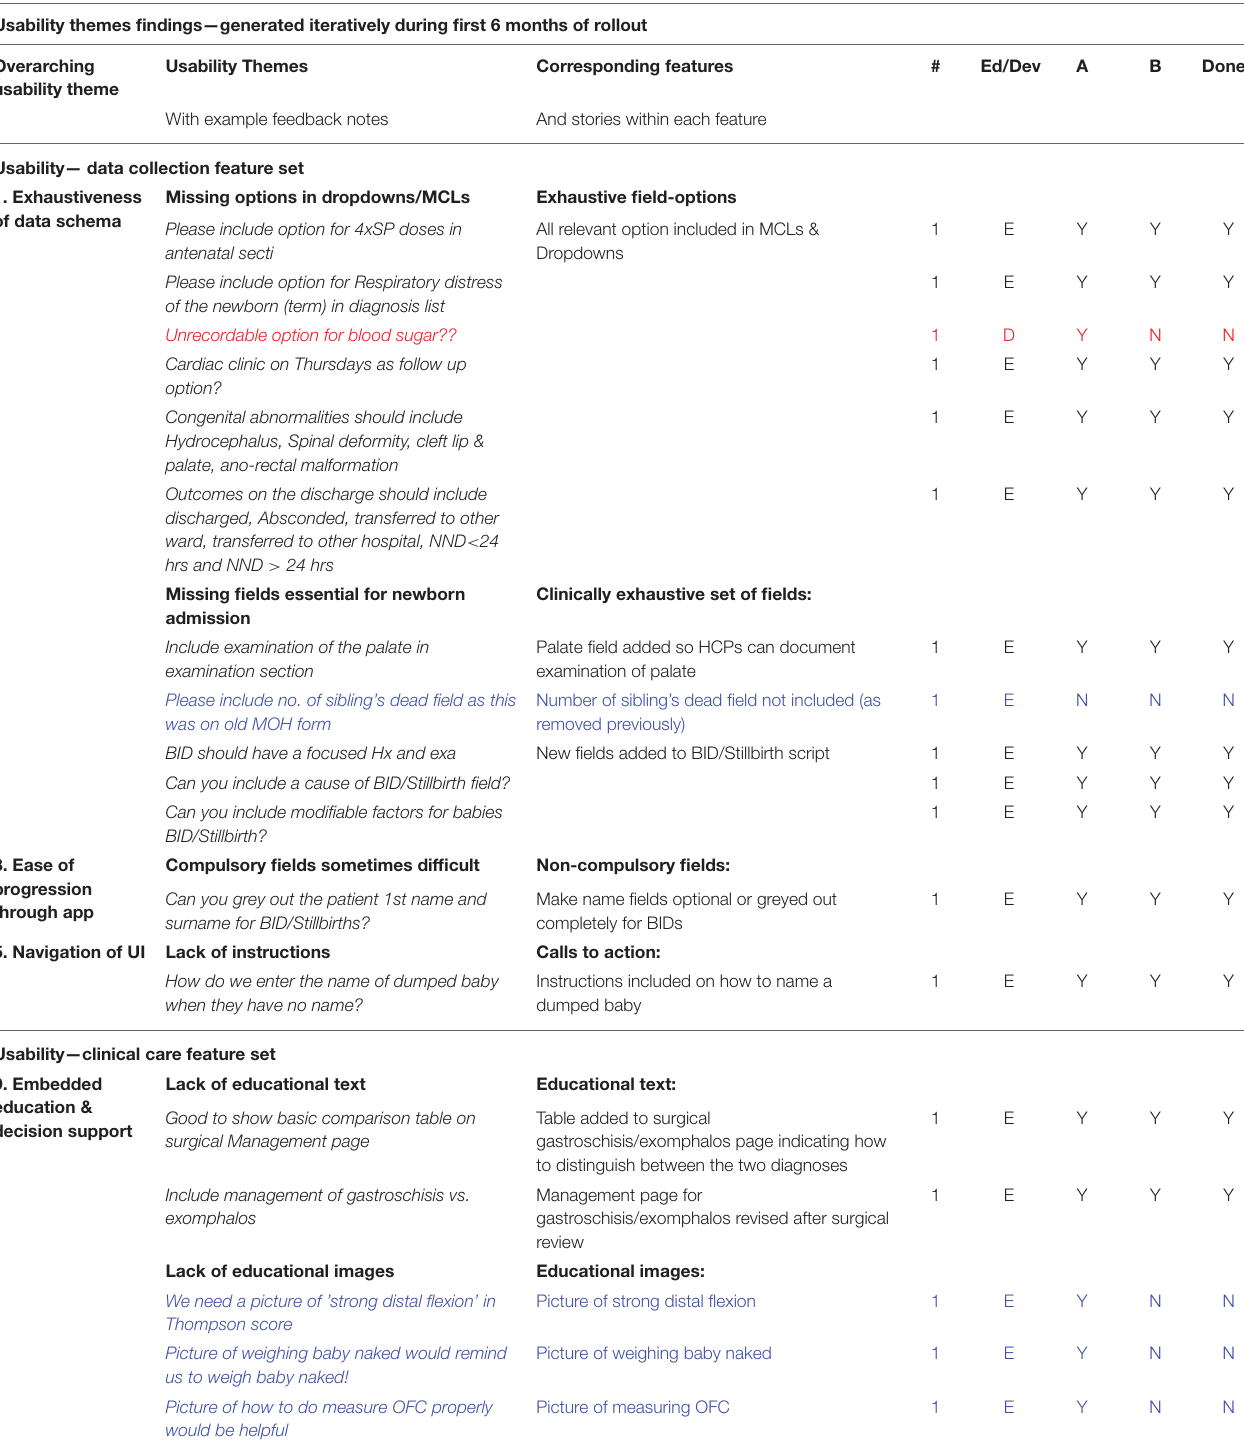
TABLE 6 | Usability of the NeoTree beta app – iterative changes made during real-world pilot. Usability themes findings—generated iteratively during first 6 months of rollout Overarching usability